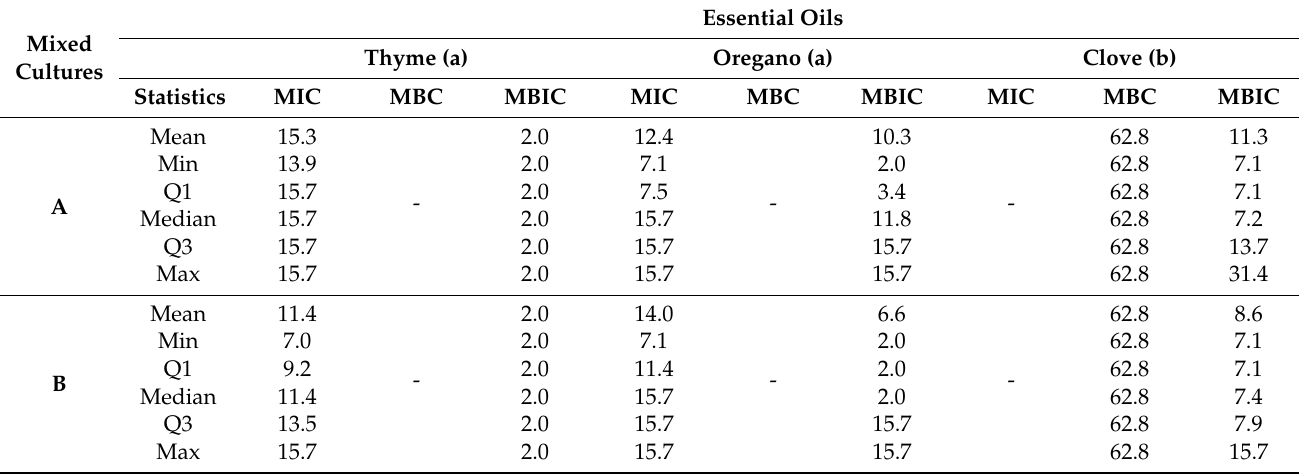
Table 2. Antimicrobial activity of essential oils against mixed cultures: the toothbrush in vitro model (values displayed in mg/mL).